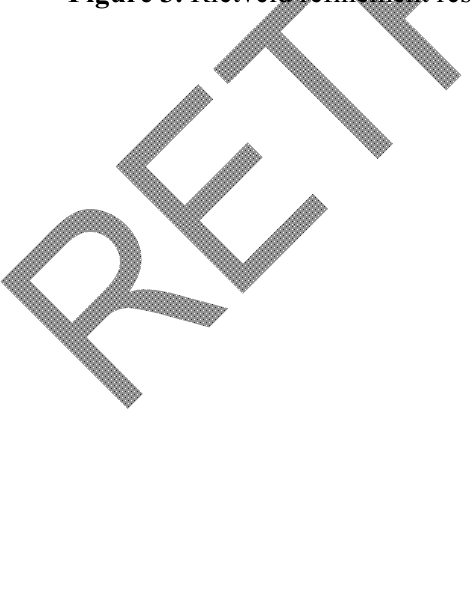
Figure 3. Rietveld refinement results of composition # 6 using different